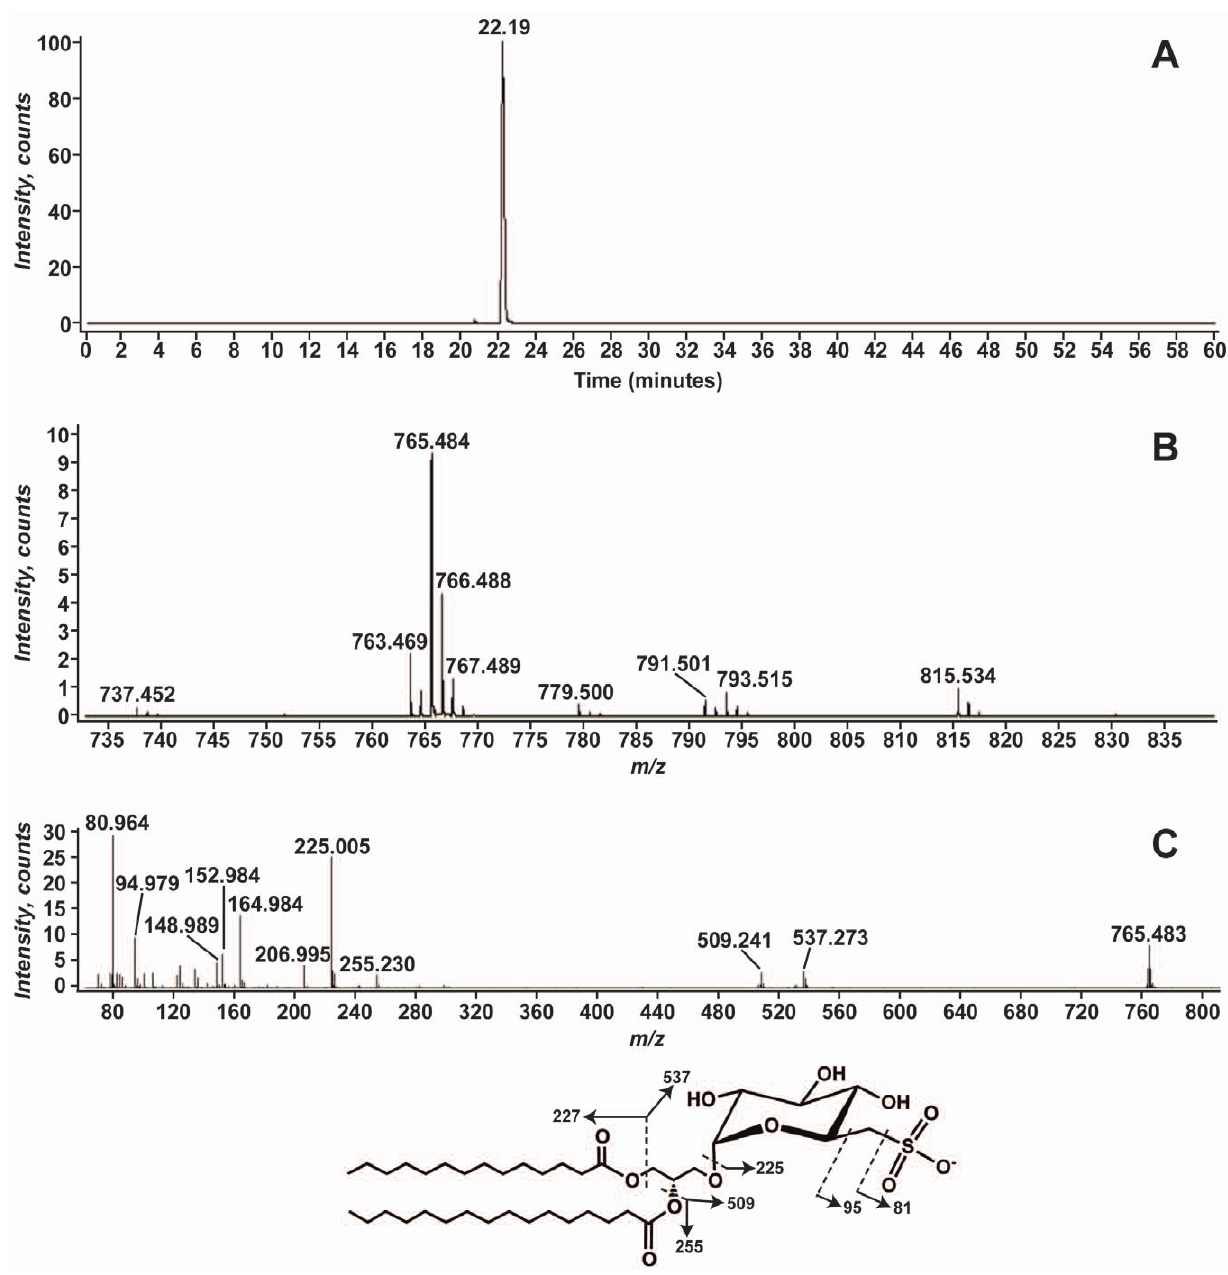
Figure 8. Negative-ion mass spectrometry of the Symbiodinium sulfolipid at m/z 765.5. Panel A shows the EIC for [M-H] 2 ion at m/z 765.5. Panel B shows the mass spectrum from m/z 735 to 835 for the lipids between 22.0 and 22.4 minutes. Panel C shows the MS/MS spectrum of m/z 765.5. The predicted structure as well as selected product ions is shown beneath the spectrum.